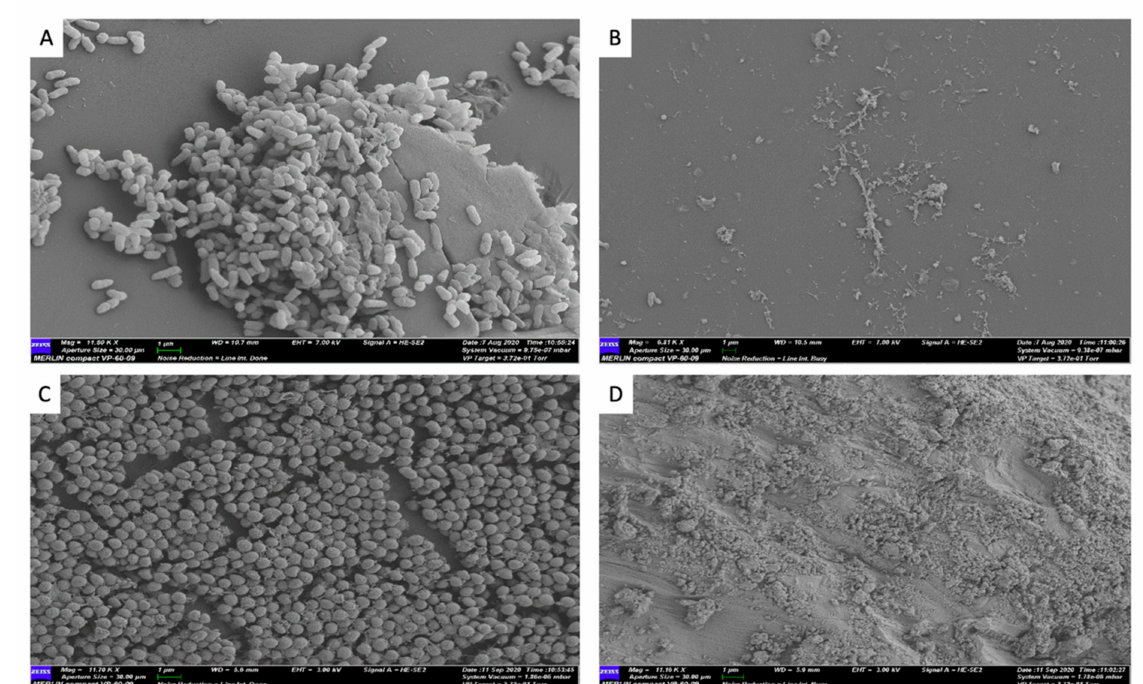
Figure 2. SEM image of P. aeruginosa ATCC-15442 biofilm on a MBEC ® peg ( A ) control at 11,800 magnification and 1 µ m and ( B ) treatment with topical MSA gel solution for 30 s at 6,800 magnification and 1 µ m. SEM image of S. aureus ATCC-6538 biofilm on a MBEC ® peg ( C ) control at 11,700 magnification and 1 µ m and ( D ) treatment with topical MSA-DMSO gel solution for 30 s at 11,160 magnification and 1 µ